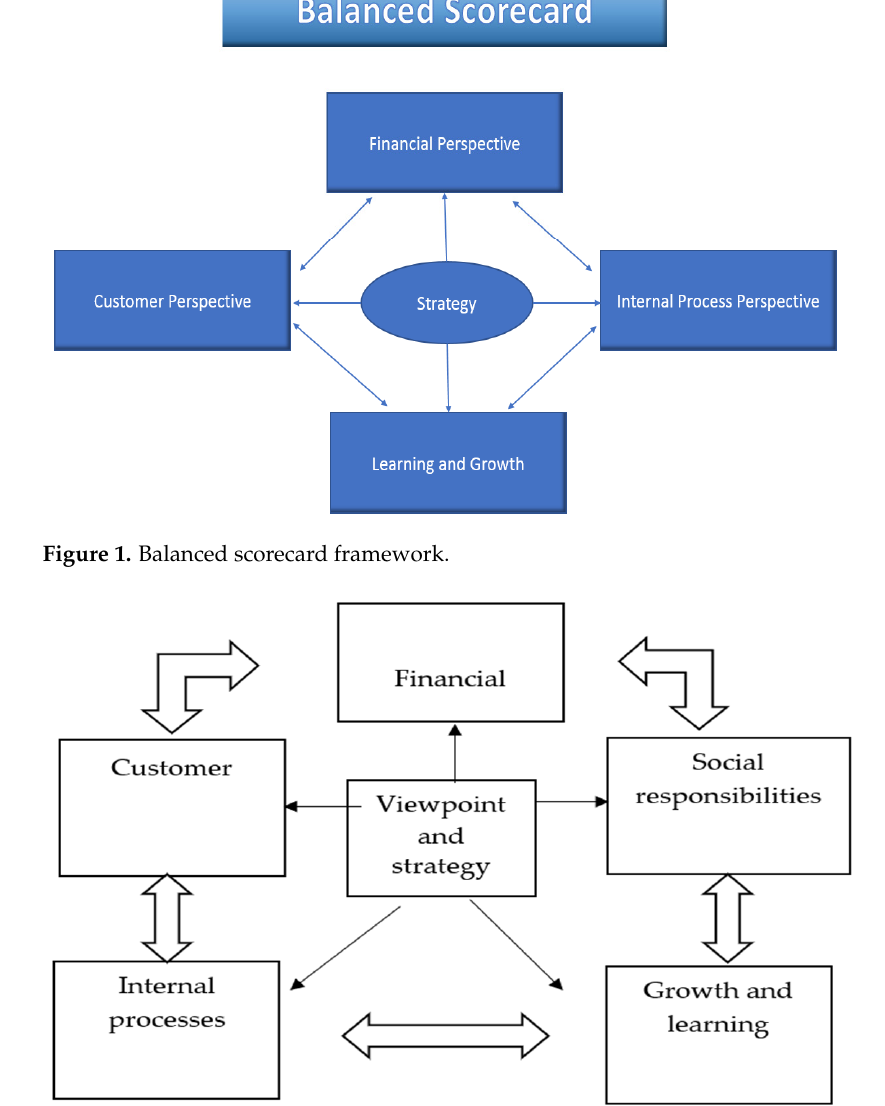
Figure 1. Balanced scorecard framework.